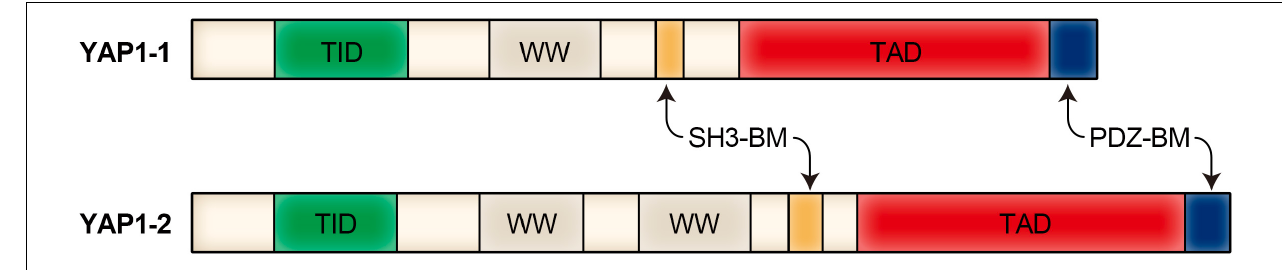
FIGURE 1 | Modular structure of YAP1